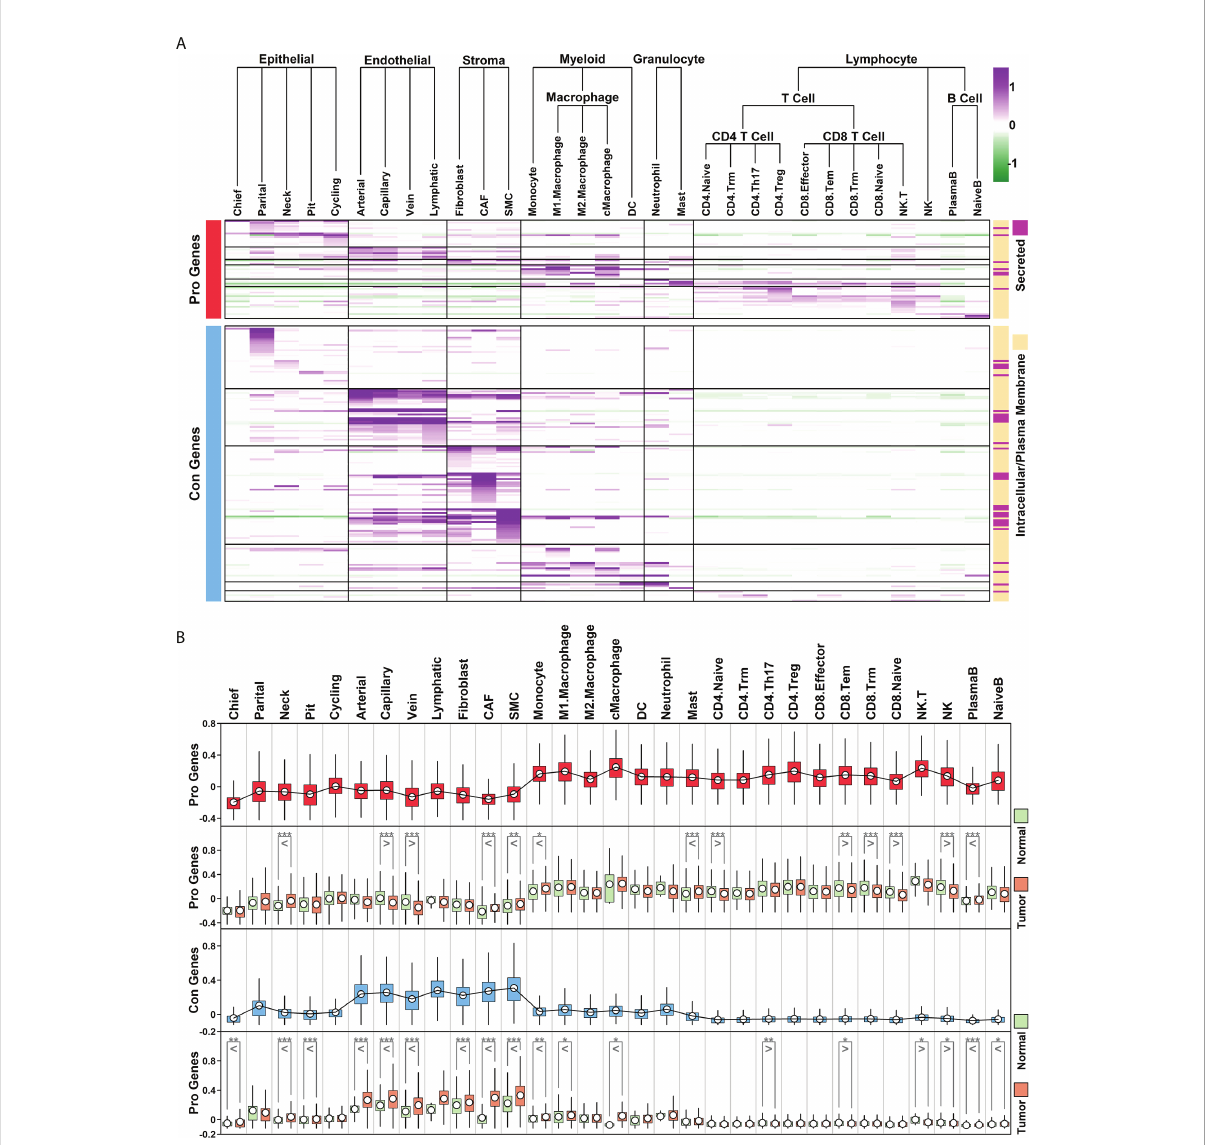
FIGURE 5 Cellular expression pro fi les of Pro and Con genes (A) Relative expression values of Pro and Con genes in 31 subgroups. Average expression values of each gene within a certain subgroup are represented using color. The subcellular location information of each gene is indicated on the right; (B) Boxplot representing the relative expression values of Pro and Con gene cohort in different subgroups/conditions (* p < 0.05; ** p < 0.01; *** p < 0.001. Two-tailed